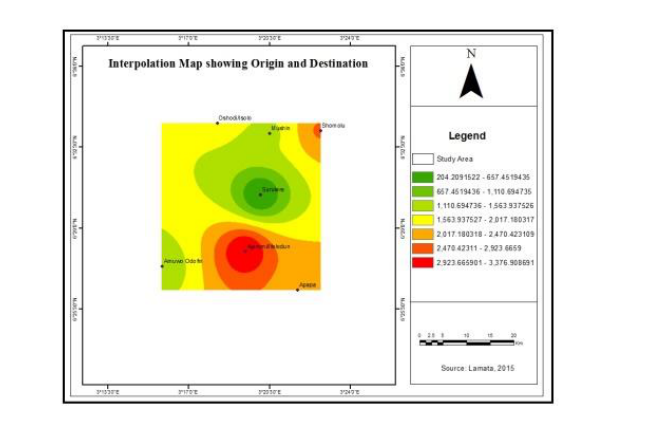
Figure 13: Traffic Pattern